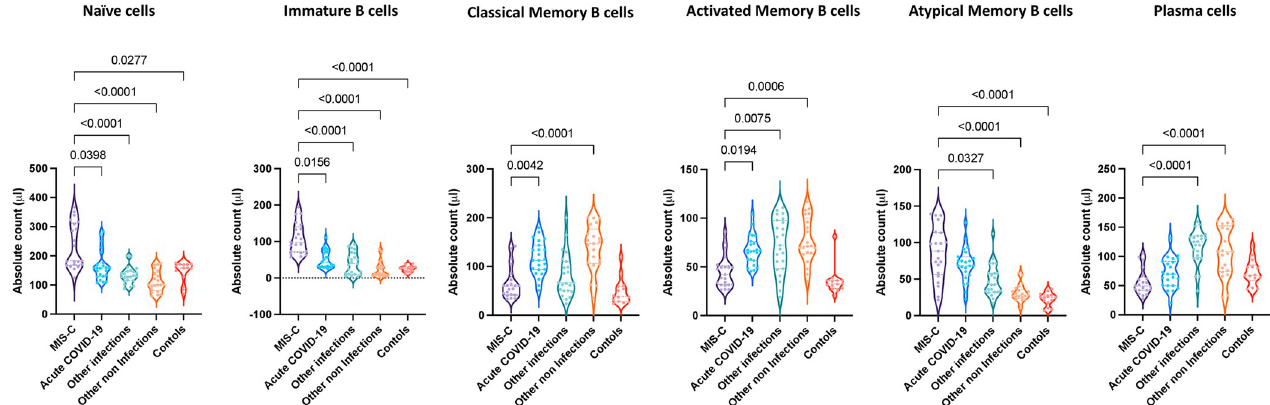
Fig 2. B cell subsets are altered in MIS-C. Absolute numbers of B cell subsets in MIS-C (n = 21), acute COVID-19 (n = 23), other infectious (n = 23), other non-infectious diseases (n = 21) and controls (n = 14). The data are represented as scatter violin plots with each circle representing a single individual. p values were calculated using the Kruskal-Wallis test with Dunn’s post-hoc for multiple